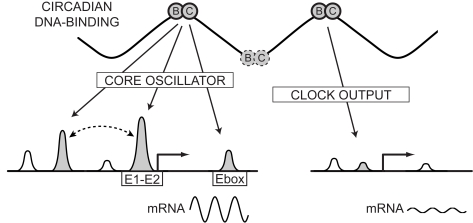
Cooperative interactions drive strong circadian amplitudes: a hypothetical model.BMAL1 rhythmically binds thousands of sites in liver, with peak binding around ZT6. Among the targets, core oscillator genes stand out as the strongest and often exhibit multiple BMAL1 binding sites. E1-E2 elements favor strong binding and precise phase-specific gene expression. The many weaker sites are distributed among clock output programs in liver, notably carbohydrate and lipid metabolism. A hypothesis for the differential binding and circadian amplitude of mRNA outputs between core oscillator genes and clock outputs is that strong sites use cooperative interactions with other regulators, or between multiple BMAL1 sites.